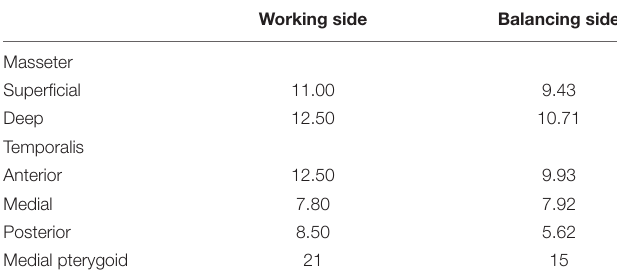
TABLE 2 | Stiffness of elastic elements c